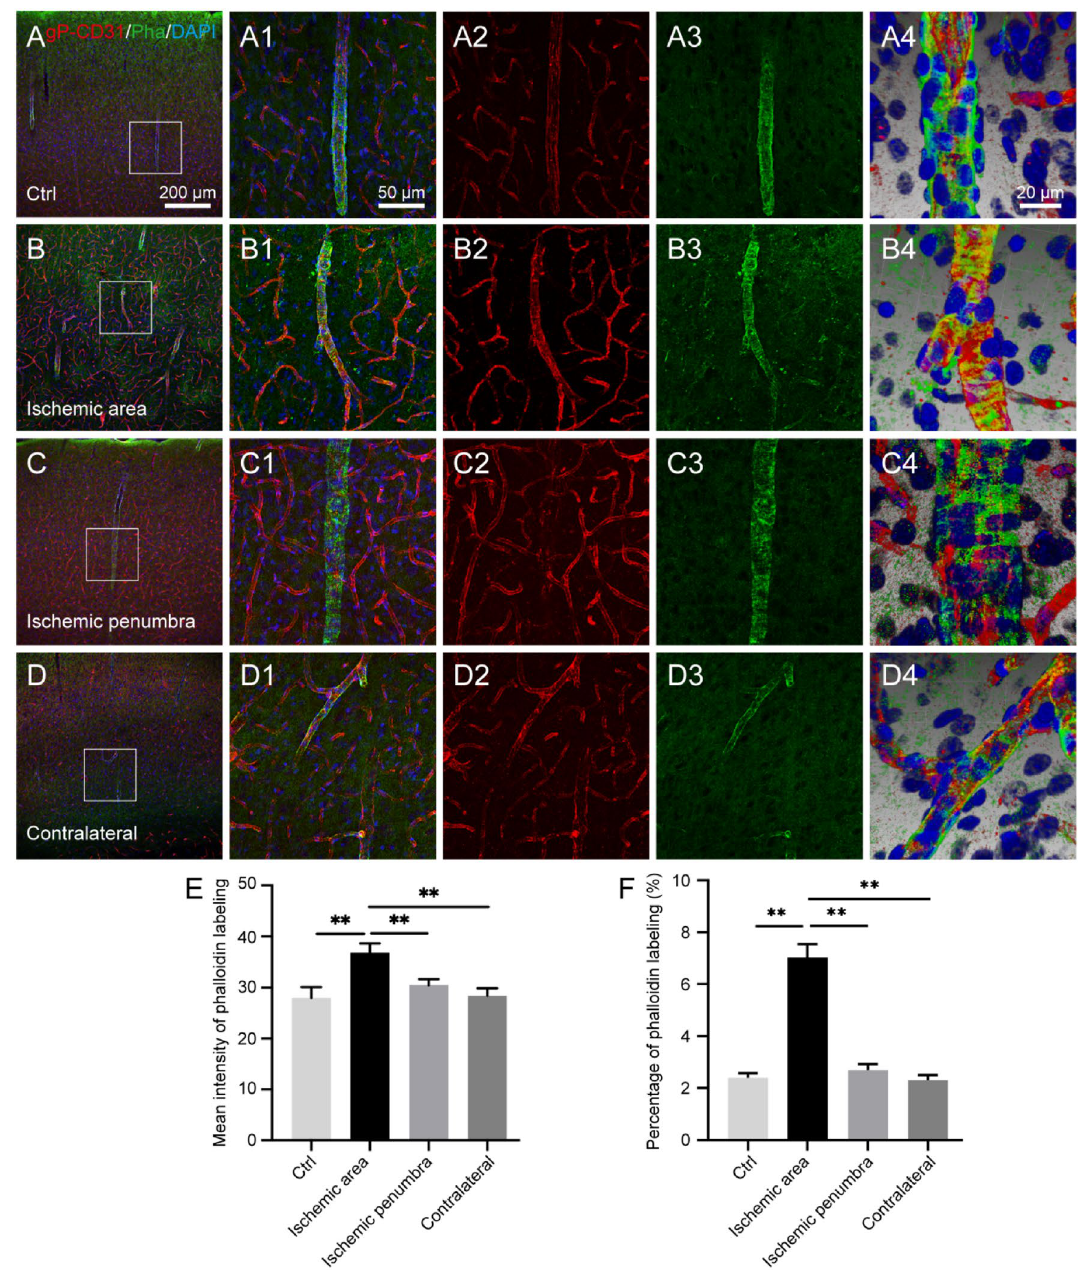
Figure 5. Comparing the distribution of cortical vascular labeling between goat polyclonal anti-CD31 (gP-CD31) and phalloidin (Pha) in the healthy and ischemia/reperfusion rat brains. ( A – D ) Representative photographs from the cerebral cortex showing the difference of vascular labeling with gP-CD31 (red) and phalloidin (green), including the normal region ( A ), ischemic region ( B ), ischemic penumbra ( C ), and matching contralateral region ( D ). ( A1 – D1 ), ( A2 – D2 ), ( A3 – D3 ) Corresponding magnified photographs from panels ( A – D ) (box-indicated regions) showing the detailed vascular labeling ( A1 – D1 ) separately with gP-CD31 ( A2 – D2 ) and phalloidin ( A3 – D3 ), and further adjusted with three-dimensional reconstruction showing the spatial relationship of vascular labeling with gP-CD31 and phalloidin in detail ( A4 – D4 ). The cellular nucleus was stained by DAPI (blue). ( E , F ) Quantitative analysis of the labeling intensity ( E ) and the percentage ( F ) of phalloidin (n = 4 rats, 12 fields per region, ** P < 0.05). Scale bars: 200 μm in ( A – D ), 50 μm in ( A1 – D1 ), ( A2 – D2 ), ( A3 – D3 ), and 20 μm in ( A4 – D4